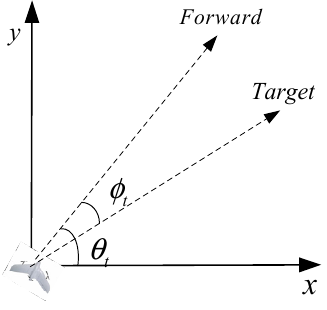
Figure 3. Diagram of the yaw angle and relative angle. According to references [21,22], the earth fixed coordinate can be used to describe the relative and absolute positions of UAVs, which are expressed as the local coordinate sys- tem shown in Figure 3. With UAVs flying at a fixed altitude, the absolute position can be θ described by yaw angle , and the relative position can be described by angle between t φ . Above all, the range observation vector, distance between two air- UAV and target t craft, yaw angle and relative angle are integrated to represent the environment space in the mission planning process,